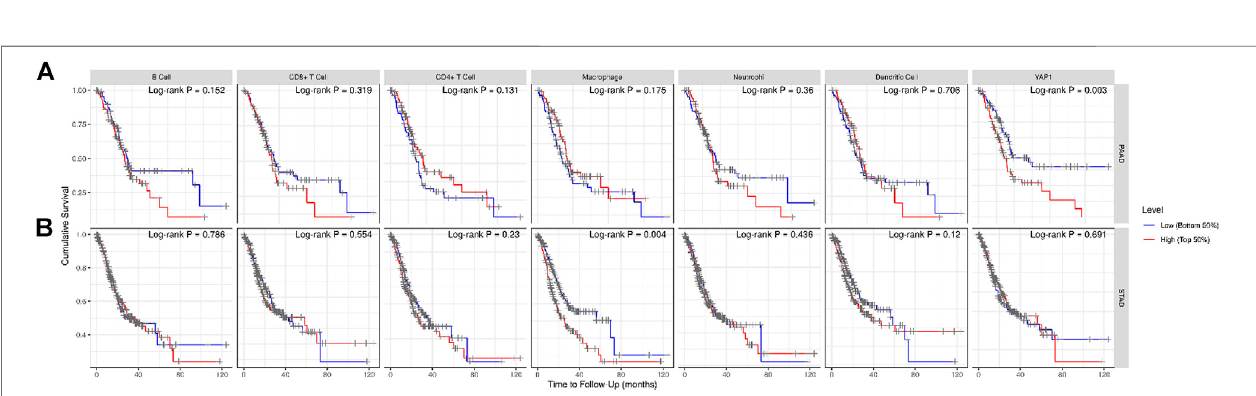
FIGURE 8 | Kaplan – Meier plots of immune in fi ltration and YAP1 expression levels in pancreatic adenocarcinoma (PAAD) and stomach adenocarcinoma (STAD).